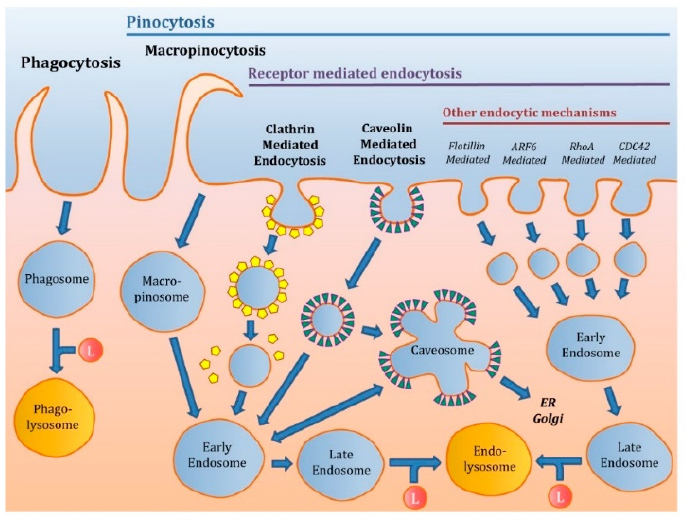
Figure 2. Principal modes of endocytosis, reproduced from [39], under creative common license.